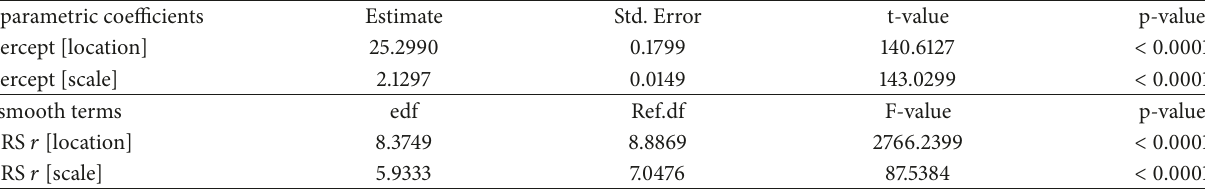
Table 2: Summary of a Gaussian location scale additive model fitted to the similarity ratings in the MEN dataset, with as predictor the correlation 𝑟 ofword’ssemanticvectorsinthe S matrix.TPRS:thinplateregressionspline.b:theminimumstandarddeviationforthelogblink function. Location: parameter estimating the mean; scale: parameter estimating the variance through the logb link function ( 𝜂 = log (𝜎 − 𝑏)